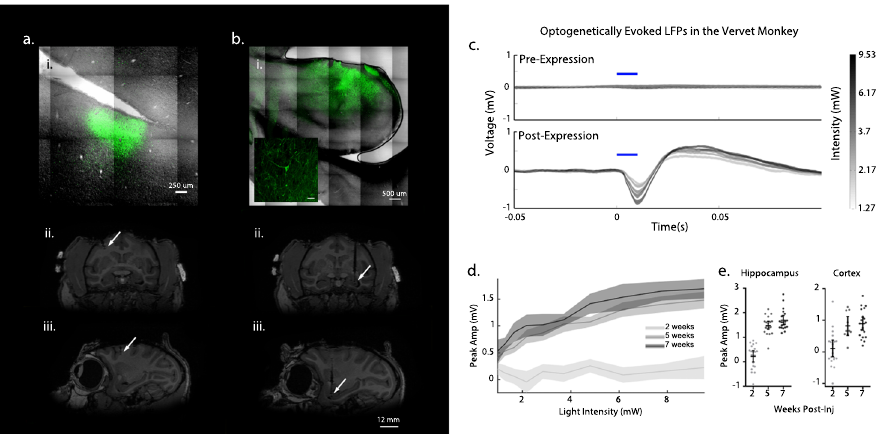
Fig. 1 Location of optogenetic protein expression and light evoked responses. a Cortical transduction and implantation. i ChR2-eYFP labeled neurons con fi ned to gray matter of the posterior wall of right arcuate sulcus corresponding to area 8a. Coronal ( ii ) and sagittal ( iii ) MRI demonstrating location of the optrode in terminal MRI (arrow). b Hippocampal transduction and implantation. i ChR2-eYFP labeled neurons in the anterior dorsolateral aspect of left hippocampus corresponding to area CA3 indicate transgene expression; inset demonstrating labeled neuron. Coronal ( ii ) and sagittal ( iii ) MRI demonstrating location of the optrode in terminal MRI (arrow). c Example of averaged response to stimulation at fi ve intensity levels (gray to black) in hippocampus showing absence of response in week 2 (upper trace) compared to the large, biphasic LFP in week 7 (lower trace). Blue bar indicates stimulus onset and duration. d Average intensity-response curves for each of the three-time points in representative animal M1.Bands = 95% CI. e Maximum intensity stimulation (9.53 mW) of cortex and hippocampus at 7 weeks post-injection elicited a response as measured by the LFP electrode that was greater than at 2 weeks post-injection in representative animal M1. ( n = 20 trials, except n = 10 trials for cortex at 5 weeks). Center line = mean, error bars = 95%